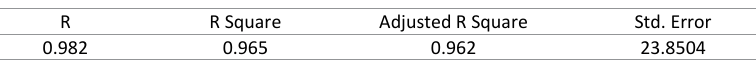
Fig. 5: usage of water-related appliances in the home Table 3: Linear regression analysis